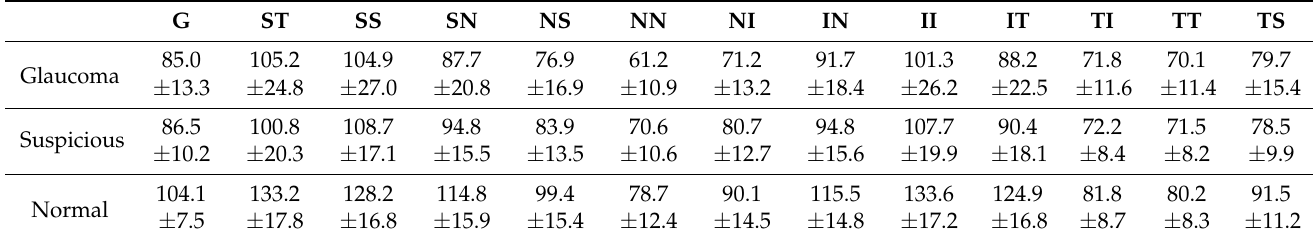
Table 4. Summary of estimated RNFL ( µ m) from glaucoma, suspicious, and normal groups for global and 12